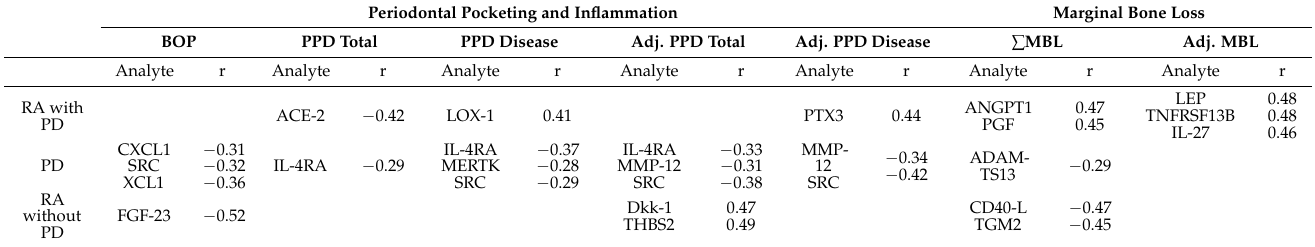
Table 2. Correlations of CVD risk biomarkers with periodontal pocketing and marginal bone loss.